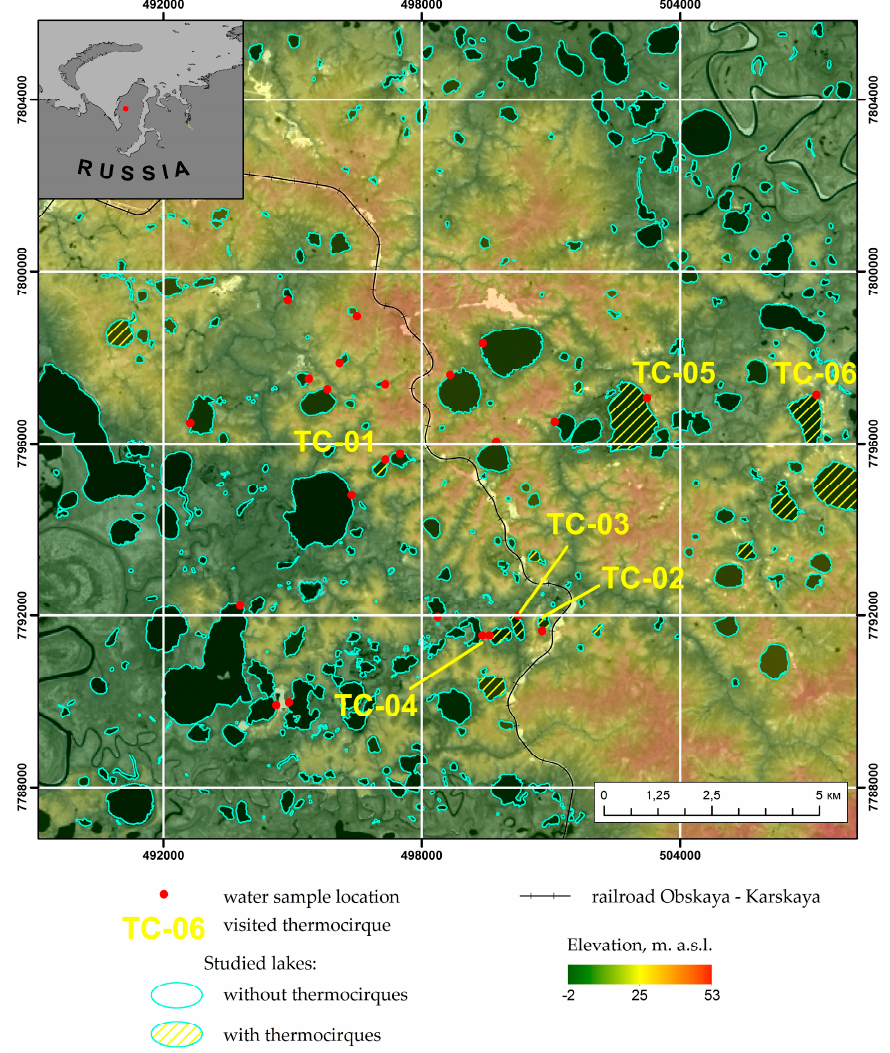
Figure 1. Map of the Vaskiny Dachi study region, showing the location of sampling (red points) during the 2014 field campaign. Thermocirques visited in the field are marked by yellow labels. Background: near-infrared band image of Landsat 8 satellite (19 July 2013) under half-transparent color-coded TanDEM-X digital elevation model (UTM Zone 42 North, WGS84).